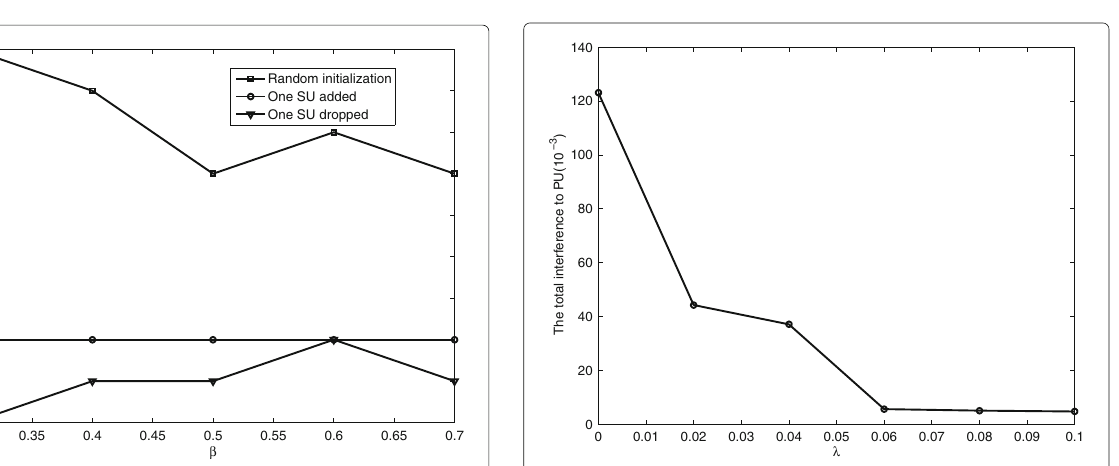
Fig. 12 The variations of the total interference to PU versus the power pricing factor